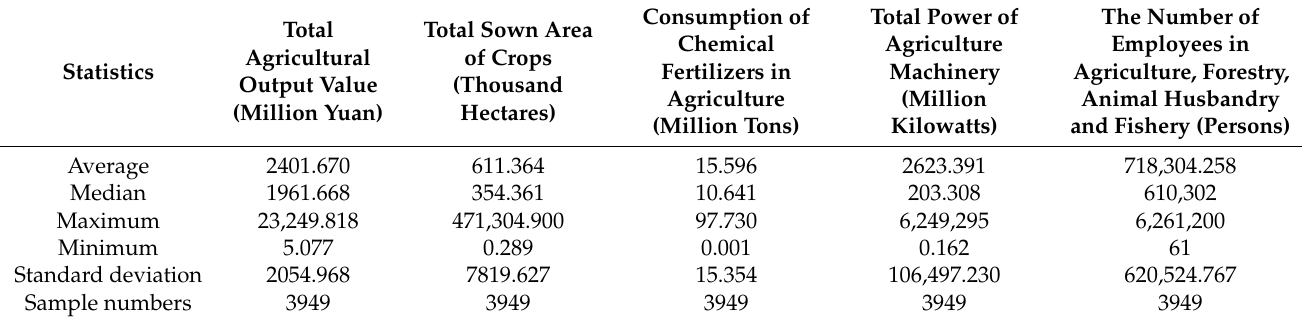
Table 1. Statistical description of output and input